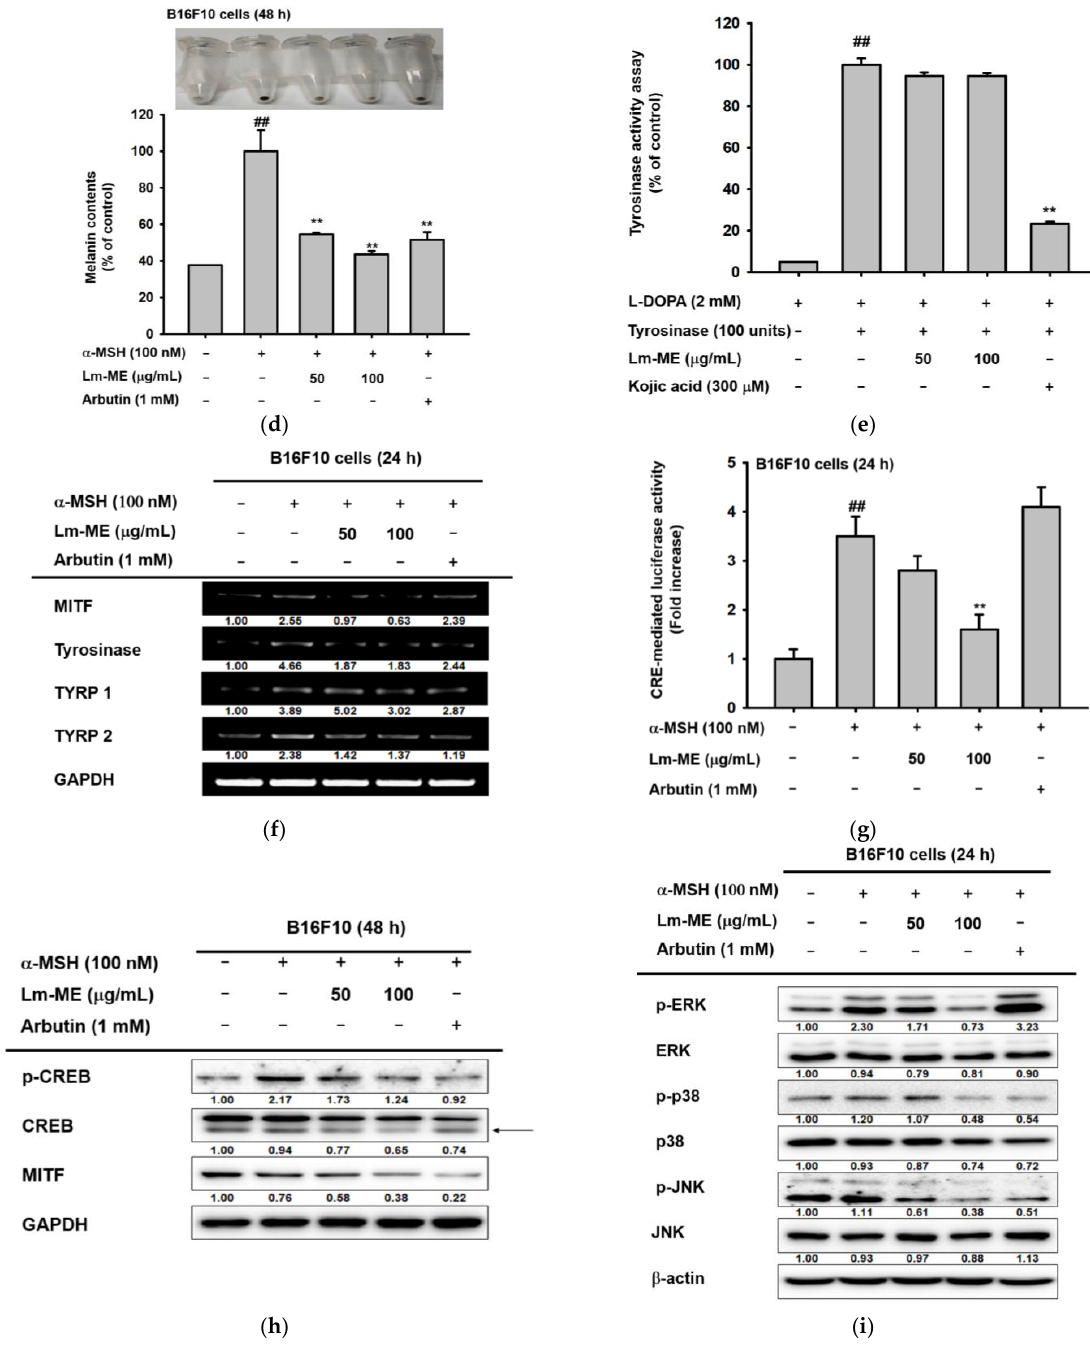
Figure 4. The anti-pigmentation effects of Lm-ME. ( a ) B16F10 cells were co-treated with α -MSH Lm-ME (0–100 µ g/mL) or arbutin (1 mM) for 48 h. Photos were taken using a Nikon Eclipse Ti inverted microscope (DS-Qi1Mc, Nikon Shinagawa, Tokyo, Japan). ( b ) The B16F10 cells were treated with Lm-ME (0–100 µ g/mL) for 48 h. The cell viability was examined with an MTT assay. ( c ) B16F10 cells were induced using α -MSH for 48 h. Lm-ME (0–100 µ g/mL) and arbutin (1 mM), as the control for 48 h. Melanin secretion was tested at 475 nm. ( d ) To measure the melanin content, the B16F10 cell pellets were lysed using a lysis buffer. The absorbance of B16F10 cell lysates was measured at 405 nm using spectrophotometry. ( e ) Tyrosinase activity was induced via mushroom tyrosinase (100 U/mL). Furthermore, 2 mM of L-DOPA and Lm-ME (0–100 µ g/mL) or kojic acid (300 µ M) was co-treated for 15 min. Next, mushroom tyrosinase was added. The absorbance of each sample was measured